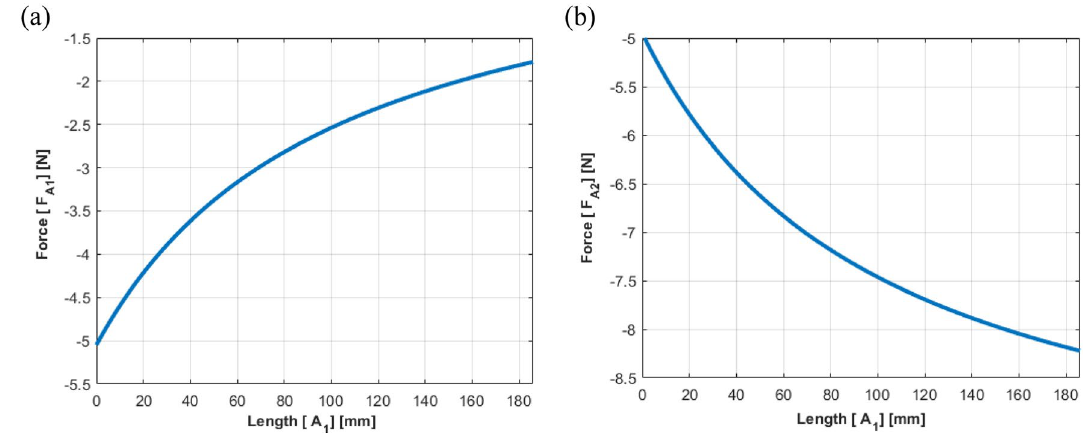
Figure 10. Actuator force estimated from the static equilibrium (case I): ( a ) path 1; ( b ) path